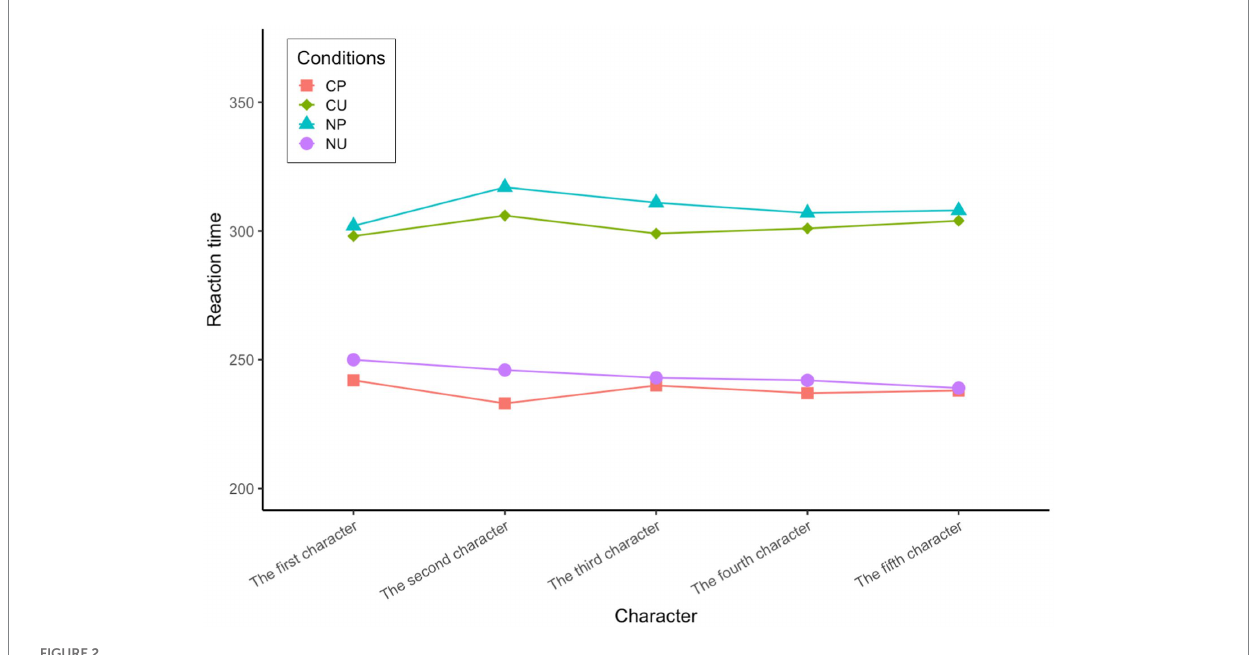
FIGURE 2 Reaction time of Chinese native speakers in four conditions.